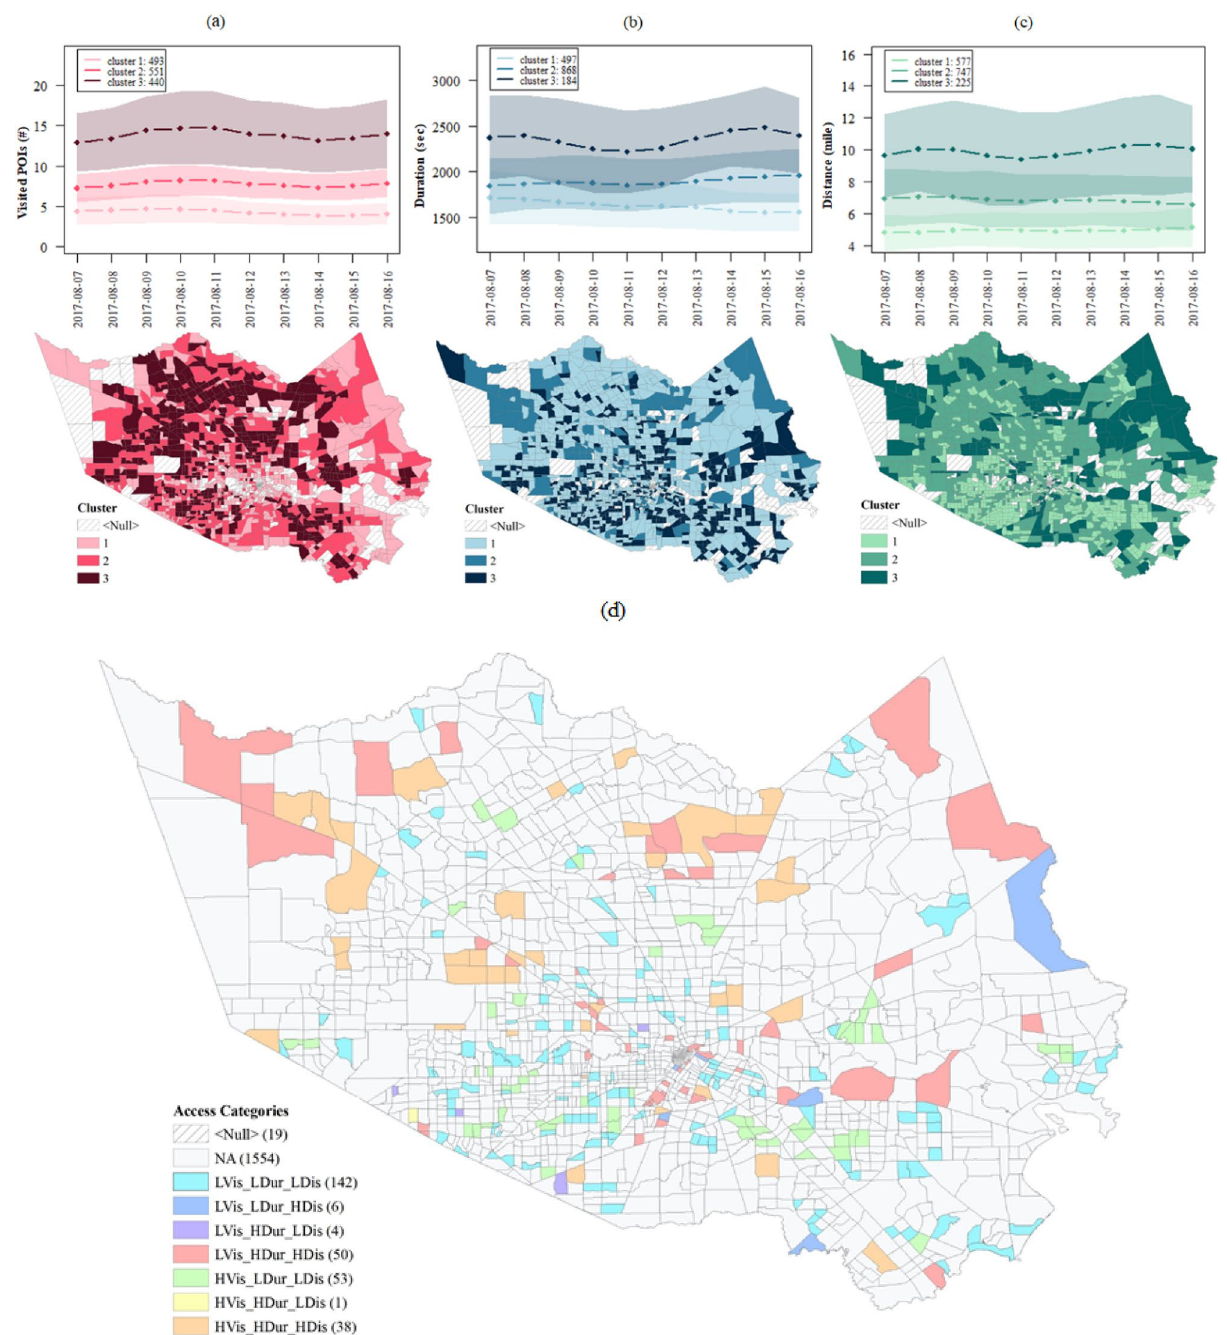
Figure 3. Clusters of access indicators during the pre-disaster normal condition. These figures show the normal condition (August 7–16) daily mean values of the indicator for each cluster in addition to the 1 standard deviation uncertainty band. The clusters show the distinct temporal and spatial patterns for access indicators: ( a) , (b) and ( c ) values for visited POIs, duration, and distance respectively; areas with a greater number of visited stores have a greater redundancy , while those areas with a greater level of duration and distance have a lower level of rapidity and proximity consecutively; categorized areas based on the access indicators of the high (H) and low (L) levels; the number of TAZs in each group are shown in parenthesis ( d